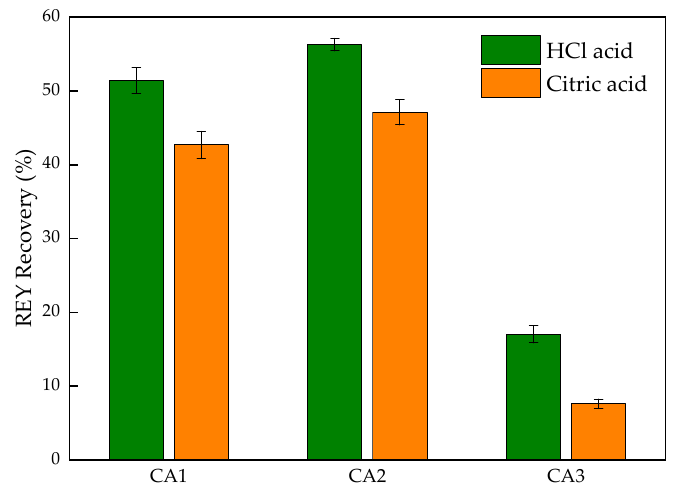
Figure 8. Rare earth elements in three coal ash samples.